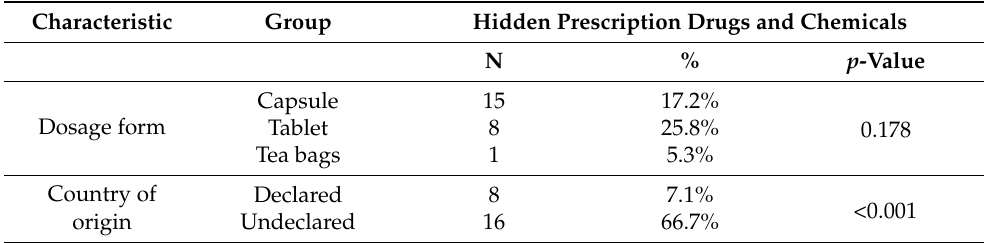
Table 5. Comparison of hidden prescription drugs and chemicals according to sample